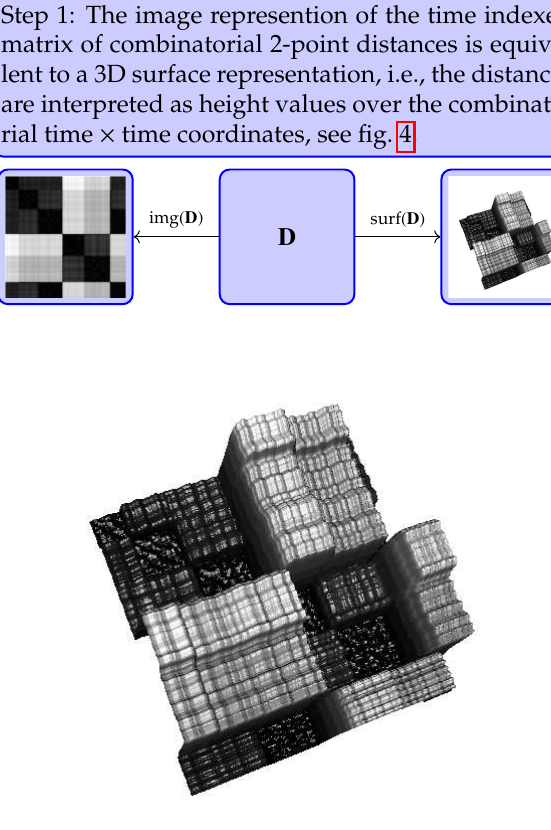
Figure 4 . Surface plot of time indexed matrix of combi- natorial 2-point distances